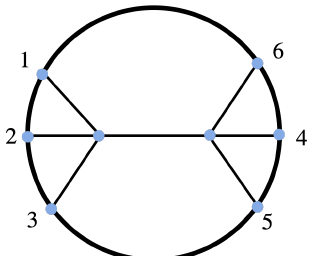
Figure 10 . The exchange Witten diagram with two bound states can be obtained from a six-point exchange Witten diagram by taking a double coincidence limit where x